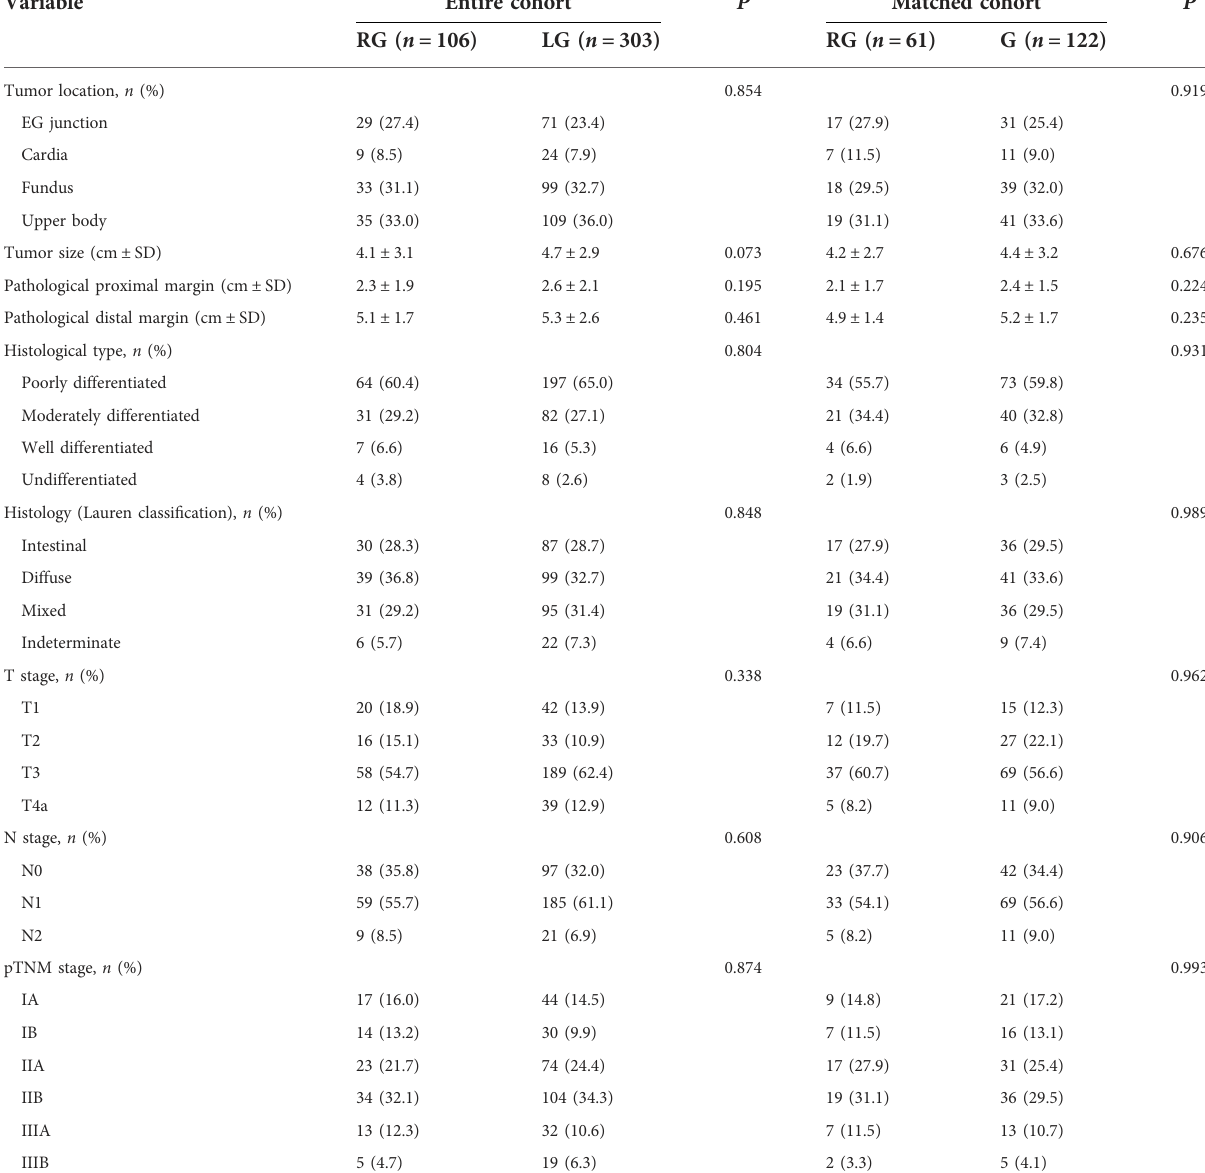
TABLE 3 Oncologic and pathologic outcomes.